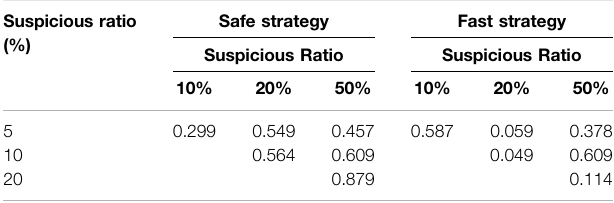
TABLE 13 | Precision scores ’ p -values between different suspicious ratios.